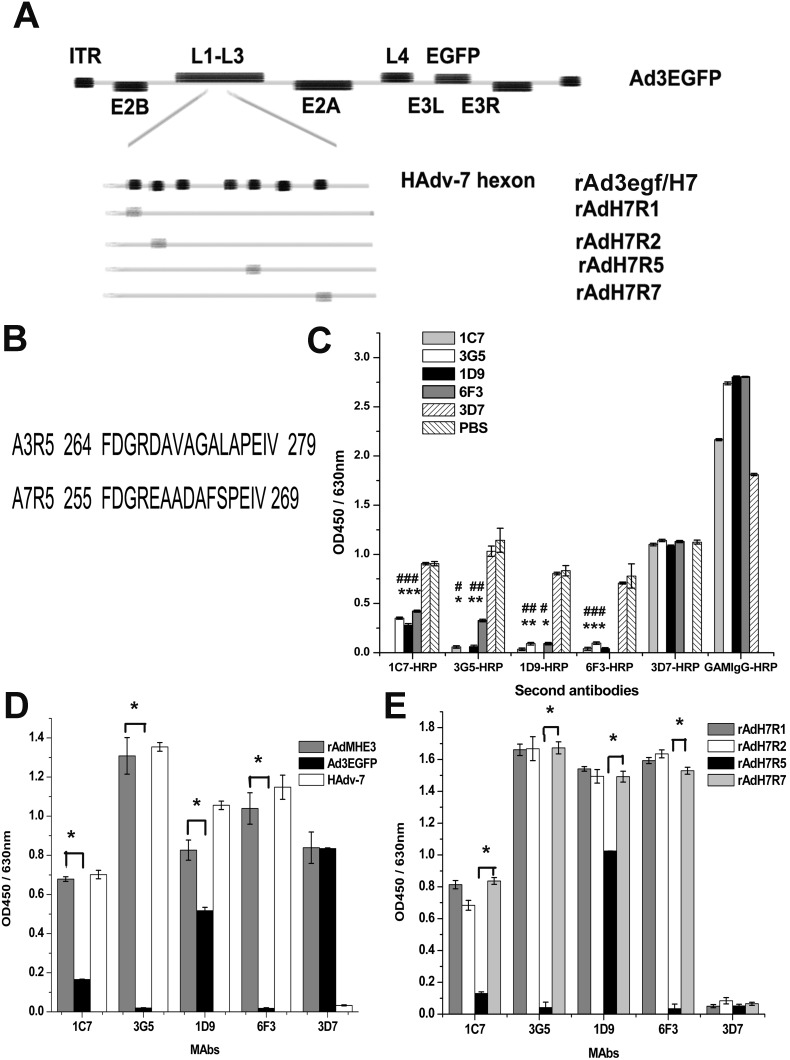
Identification of HAdv-7-neutralizing MAbs.(A) Schematic depiction of four rAd3/H7-based chimeric-hexon vectors. Epitopes derived from the HAdv-3 hexon (R1, R2, R5, and R7) are shown as gray boxes [18]. (B) HVR5 sequences of HAdv-3 and HAdv-7. (C) Analysis of an antibody-binding-competition ELISA. 96-well plates were coated with purified rAdMHE3 virions and reacted with HRP-labeled MAbs after saturation with the first MAb. 3D7, PBS, and HRP-conjugated goat anti-mouse IgG (H+L) secondary antibody (GAMIgGHRP) were used as the controls. When the binding sites were saturated with the neutralizing MAb 1C7, 3G5, 1D9, or 6F3, the subsequent binding of any other neutralizing antibody was significantly inhibited compared with the subsequent binding in the 3D7 saturation group or the PBS group. For the binding signal comparisons between each saturation group with the 3D7 saturation group, *P<0.001. For the binding signal comparisons between each saturation group with the PBS group, #
P<0.001. (D) Indirect ELISA analysis of MAbs binding to purified wild-type or recombinant virus particles. 3D7 is one of the 22 MAbs isolated from mice vaccinated with rAdMHE3 virions. We used 3D7 here as a control. *P<0.001. (E) Indirect ELISA of MAbs binding to purified epitope mutants. *P<0.001. Each experiment was repeated independently at least three times, and the mean values and standard deviations (indicated by the error bars) are shown.